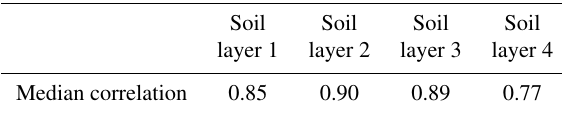
Table 1. Median catchment correlation scores over all 669 catch- ments for the training period for each soil water layer, 1